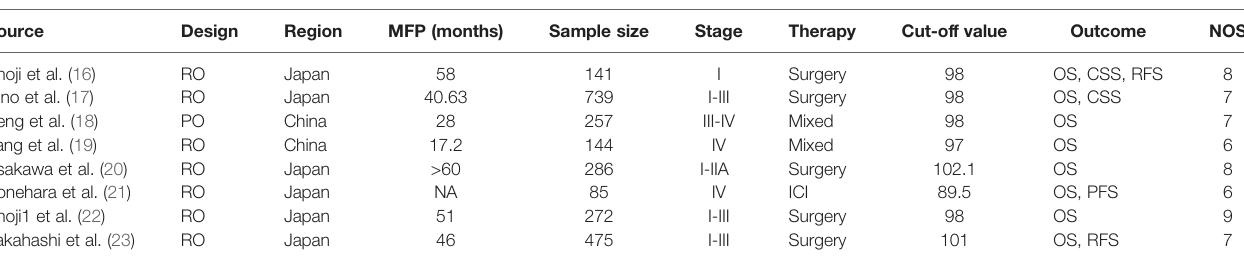
TABLE 1 | Main characteristics of the studies